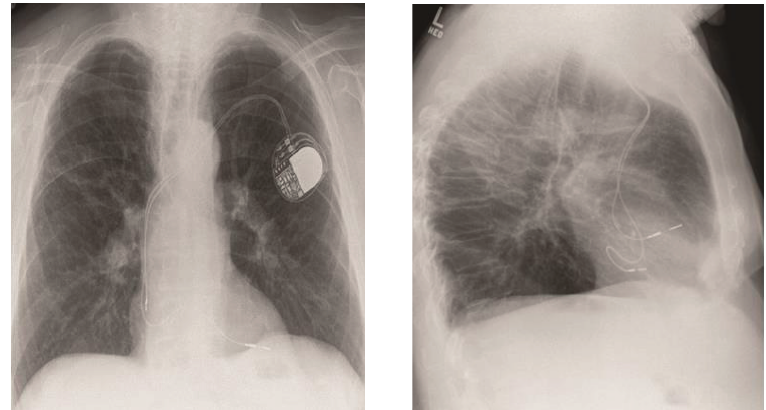
Figure 2: Chest radiograph PA and lateral projection showing the ventricular lead with an abnormal configuration.